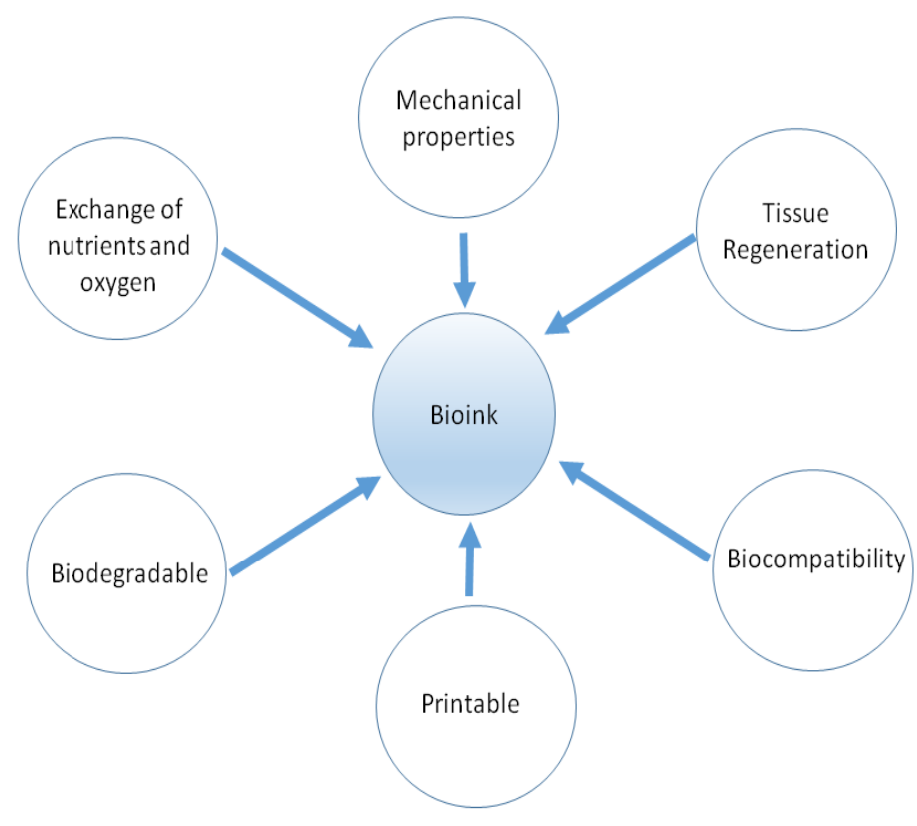
Figure 5. Properties of bioinks to consider for three-dimensional (3D) bioprinting.